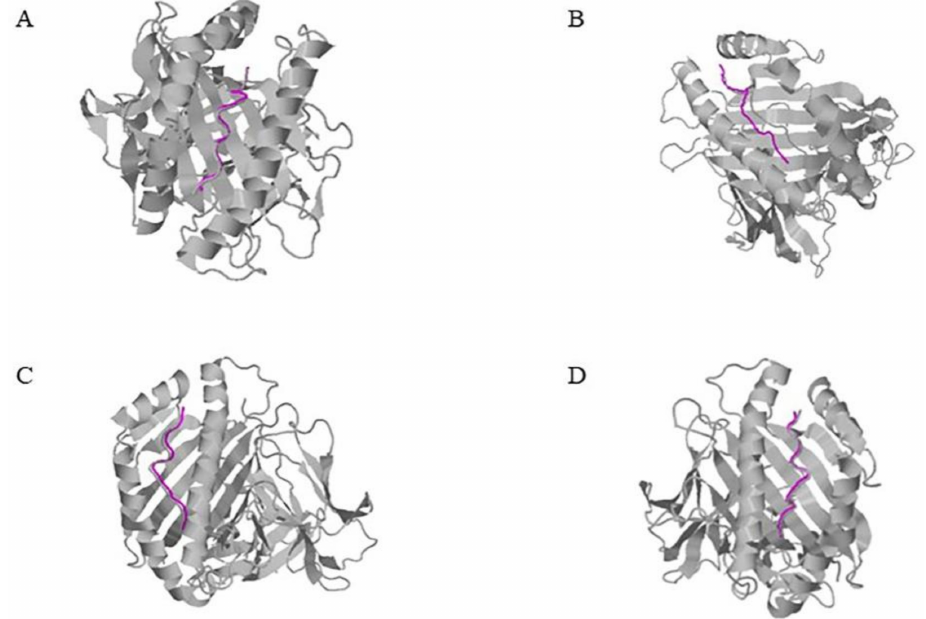
Figure 1. Modelled structure docking model. Ligands for modelled receptor structures and modelled template structures are shown in gray and predictive ligands are colored in magenta.